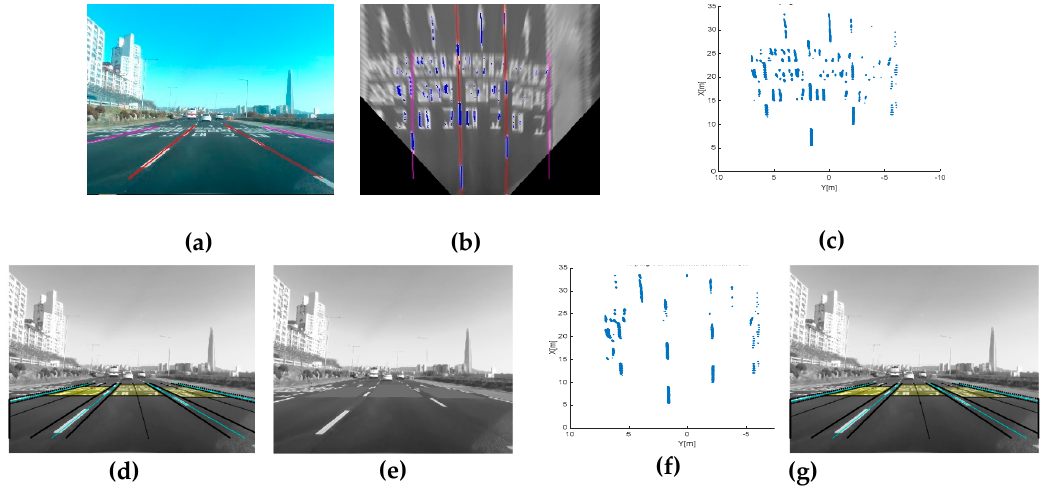
Figure 10. Complex road conditions: ITOM-based road markers elimination. ( a ) Previous multi-lane states of the image frame, ( b ) top-view frame, ( c ) origin features, ( d ) ITOM process, ( e ) remove road marker, ( f ) features in the vehicle coordinates, ( g ) multi-lane detection.